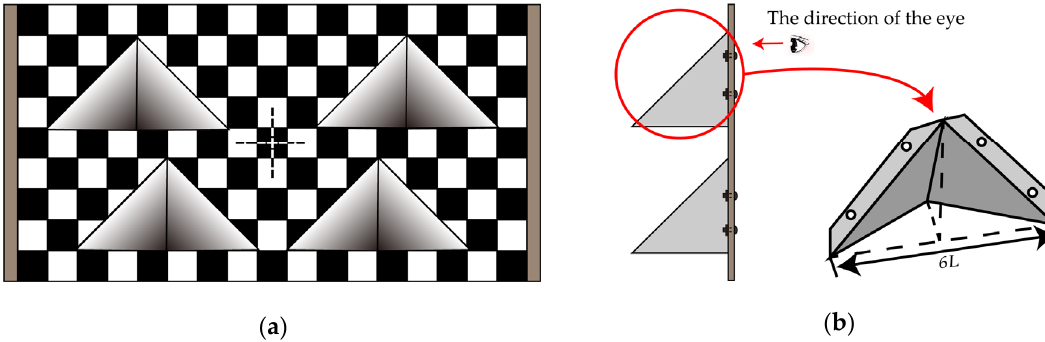
Figure 2. Schematic diagram of main plane square corner information (BWDC). ( a ) The elevation of BWDC. ( b ) The right elevation of BWDC and a partially enlarged depth gradient baffle structure.